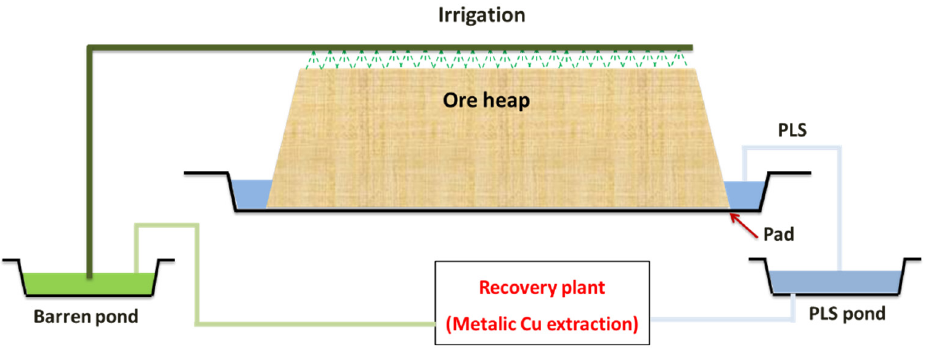
Figure 1. Typical heap leach flow diagram for copper (modified from [25]).